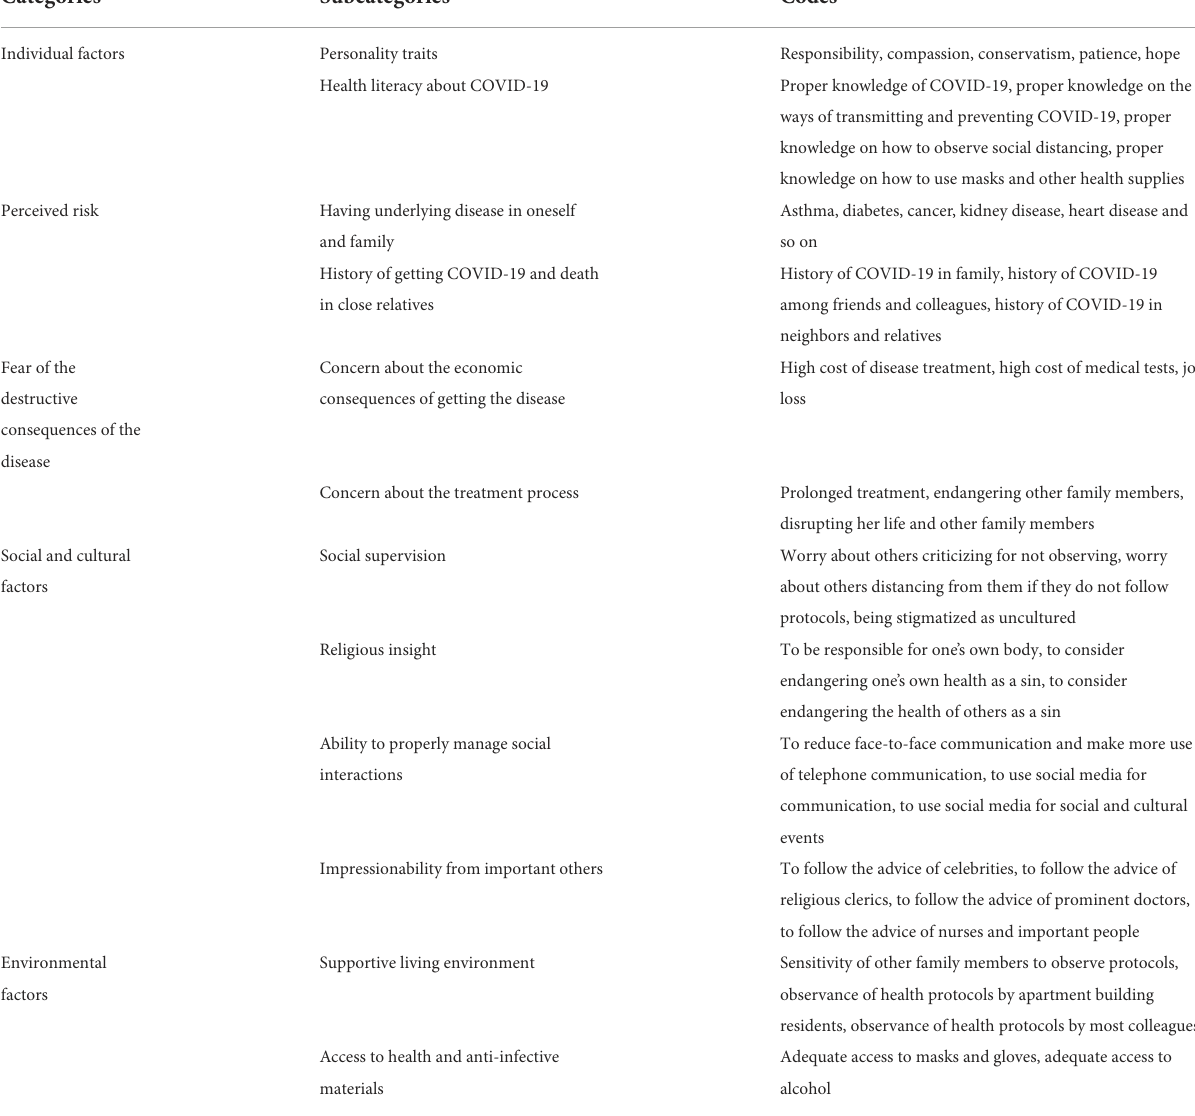
TABLE 3 Codes, categories and subcategories obtained from interviews with participating